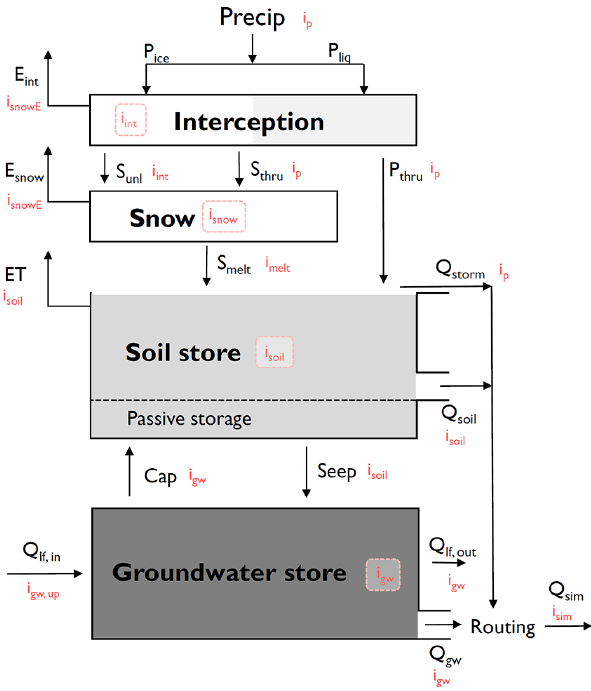
Figure 4. Schematic model structure of each model cell in STARR. Black arrows and boxes refer to water fluxes/storages, red i notation indicates the isotopic ratio of the given flux/storage. Calculation of variables and storages are presented in Appendix